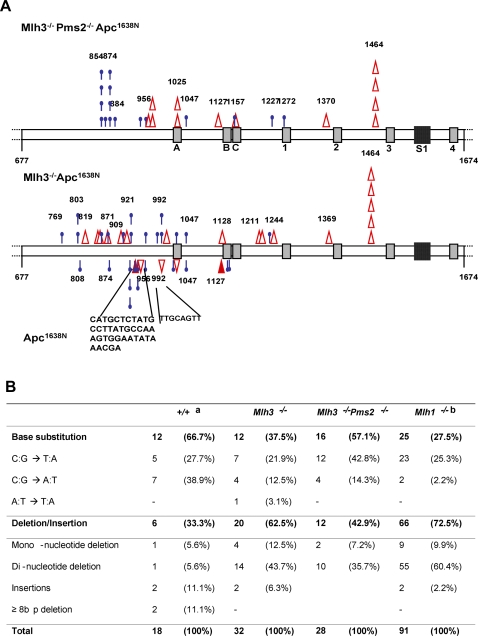
Distribution of Apc mutations.(A) Diagram of Apc between codons 677 and 1674 showing positions and characteristics of truncation mutations detected in MPA (top), MA (middle) and Apc1638N (bottom) gastrointestinal tumors. (Open triangle symbol, deletion; solid triangle, insertion; blue bar, substitution). Each symbol represents an independent mutation. Note the common hotspots at position 1464 in both strains. The three 15-aa (A–C), four 20-aa (1–4) β-catenin binding repeats and one SAMP repeat in this segment of Apc are indicated. The two nuclear export signals are at the ends of the third and fourth 20-aa repeats. (B) Spectrum of Apc truncation mutations in MMR deficient Apc1638N tumors. a Combined with previous data from Wong et al, 2002. b Data from Kuraguchi et al, 2000, for comparison.